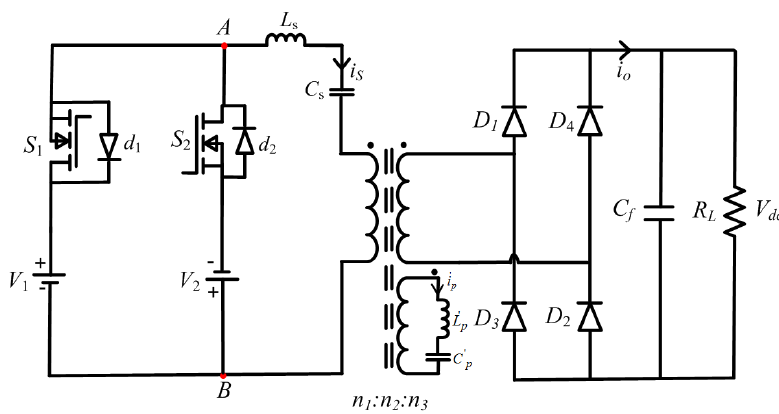
Figure 1. Proposed dual-input single output isolated resonant